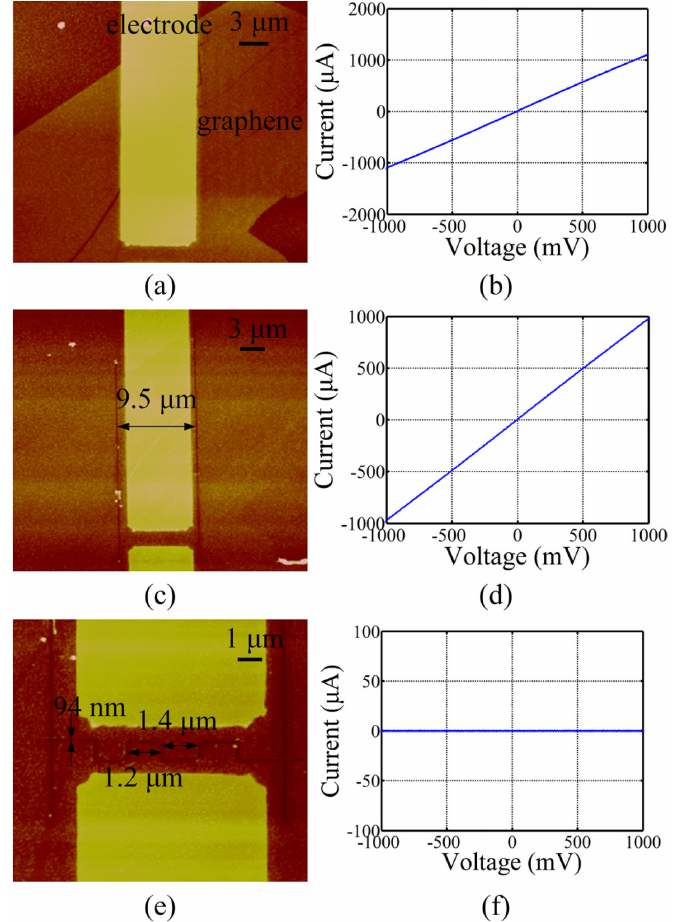
Figure 8. Height image of the graphene ribbon. ( a ) AFM image before cutting; ( b ) I-V curve before cutting; ( c ) AFM image after the first cut. The width of the graphene ribbon between the electrodes is 9.5 µ m; ( d ) I-V curve after the first cut; ( e ) AFM image after interdigitated electrodes are formed; and ( f ) I-V curve after interdigitated electrodes are formed.